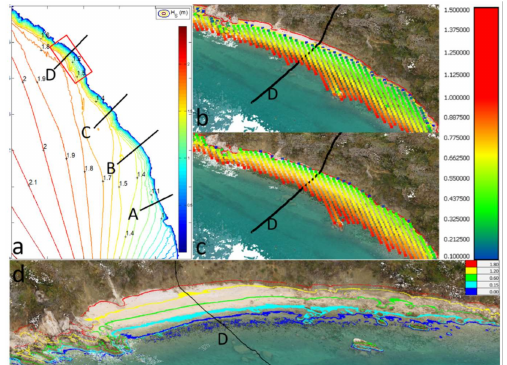
Figure 11. Significant wave heights, SE wind 50-year return period (SWAN), for investigation area ( a ) and characteristic detail for simulated sea level 1.20m ( b ) and 1.80 m ( c ). Contours (0, 0.15, 0.60, 1.20, 1.80) delivered from 3D point cloud ( d ).